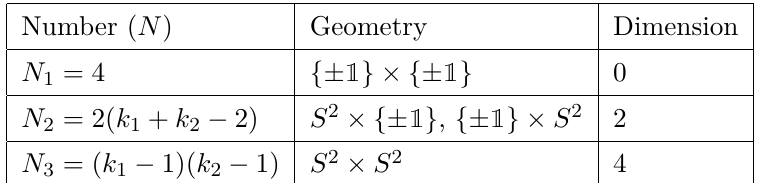
Table 1 . The product of conjugacy classes in SU (2) k ( k 1 + 1)( k 2 + 1)